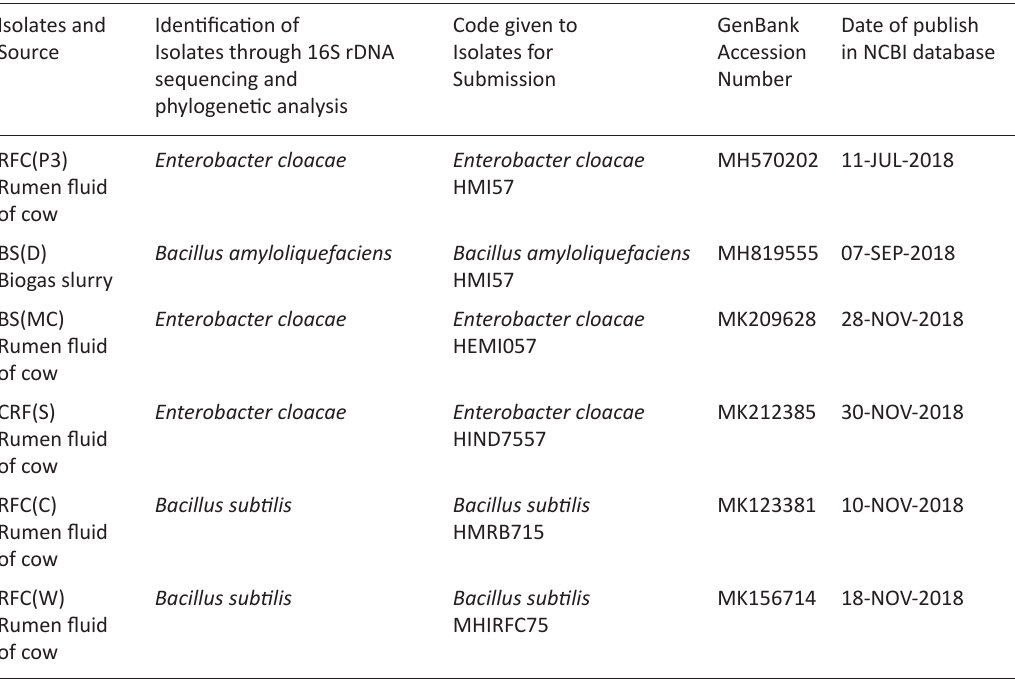
Table 1. Accession numbers of the newly isolated six strains for succinic acid production Isolates